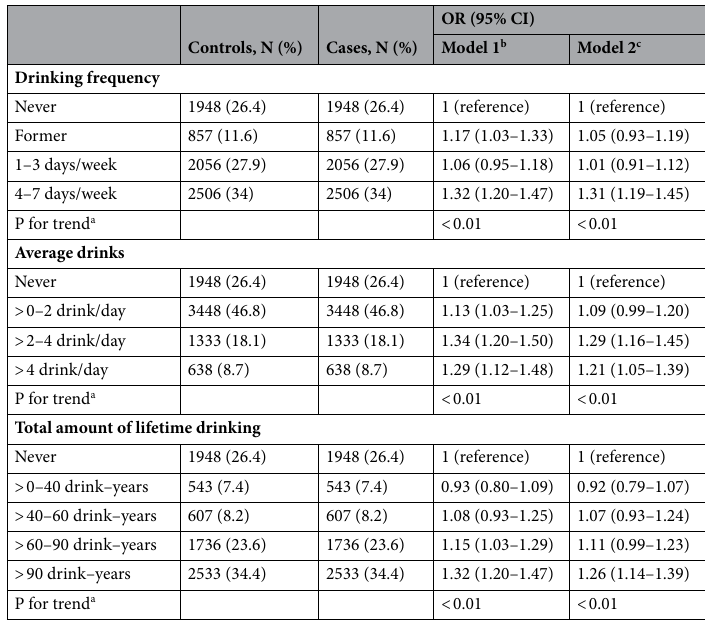
Table 3. Odds ratios for incident cataract surgery estimated with the categorical alcohol use patterns (men). OR odds ratio, CI confidence interval. a Trend test was calculated for the associations between alcohol use patterns as a continuous variable and incident cataract surgery. b Conditional logistic regression matched for sex, age, admission date, and hospital. c Additionally adjusted for smoking history, lifestyle-related comorbidities (hypertension, hyperlipidaemia, diabetes, and obesity), occupational radiation exposure, and outdoor work.